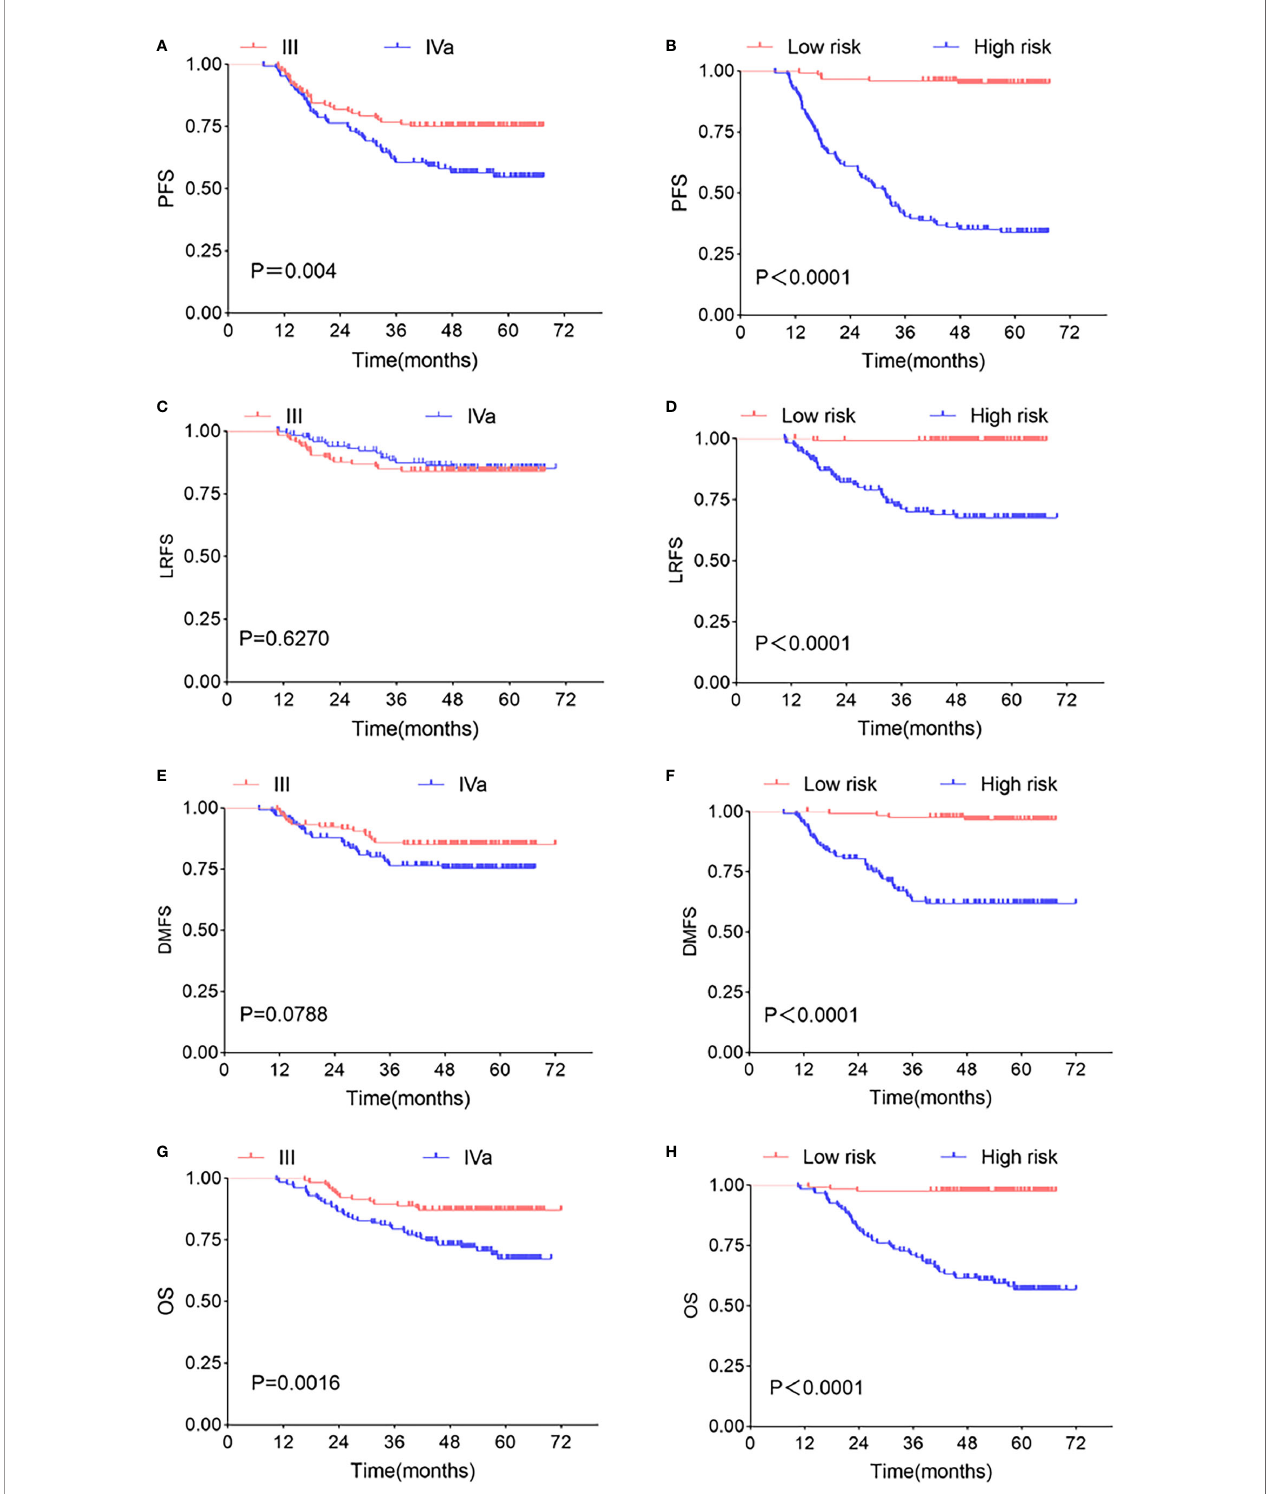
FIGURE 6 | Kaplan-Meier survival curve. Kaplan-Meier survival curves of TNM stages and two risk groups at different clinical endpoints. TNM stages in PFS (A) , LRFS (C) , DMFS (E) , OS (G) survival curve, high- and low-risk groups in PFS (B) , LRFS (D) , DMFS (F) , OS (H) survival curve. The P-value in the fi gure is obtained by the log-rank